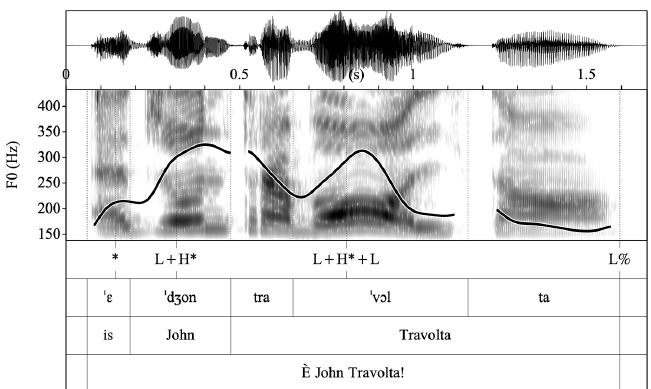
Figure 10. Waveform, spectrogram and F0 trace of the statement of the obvious It is John Travolta! in L1 Italian produced with L+H*+L L%. L1 Italian produced with L+H*+L